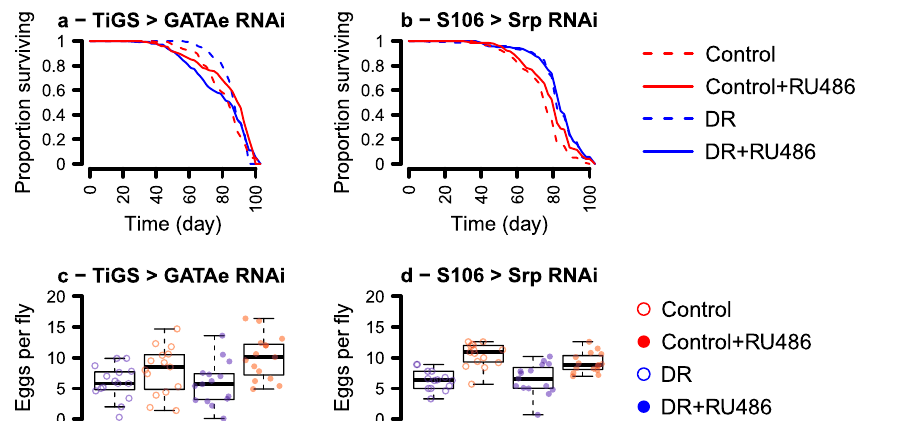
Fig. 3 Tissue-restricted knockdown of GATAe and srp interact with dietary EAAs to determine egg laying and lifespan. Survival curves of fl ies fed EAA-replete or DR media, with/without expression of RNAi against GATAe in the midgut ( a , TiGS, UAS-GATAe-RNAi ), against srp in the fat body ( b , S1106, UAS-Srp-RNAi ) Complementary egg laying indices are given in panels c – d ( c , TiGS, UAS-GATAe-RNAi ; d , S1106, UAS-Srp-RNAi ). Control medium was EAA-replete. Survival curves show proportion surviving over time. Box plots show medians, fi rst and third quartiles, and whiskers extend 1.5 × interquartile range, with points showing individual data